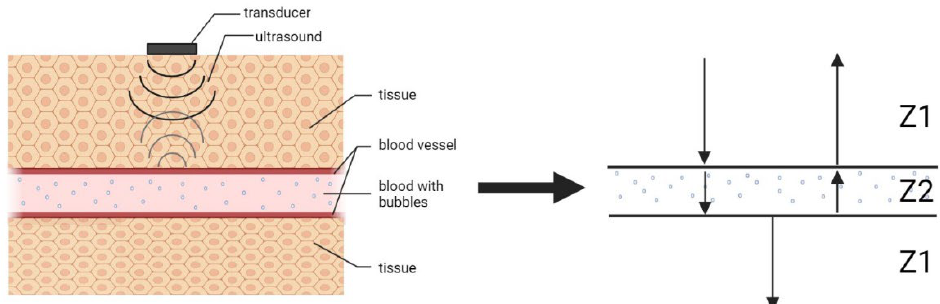
Figure 2. Model of acoustic normal incidence in a multilayer medium containing a bubbly liquid layer.